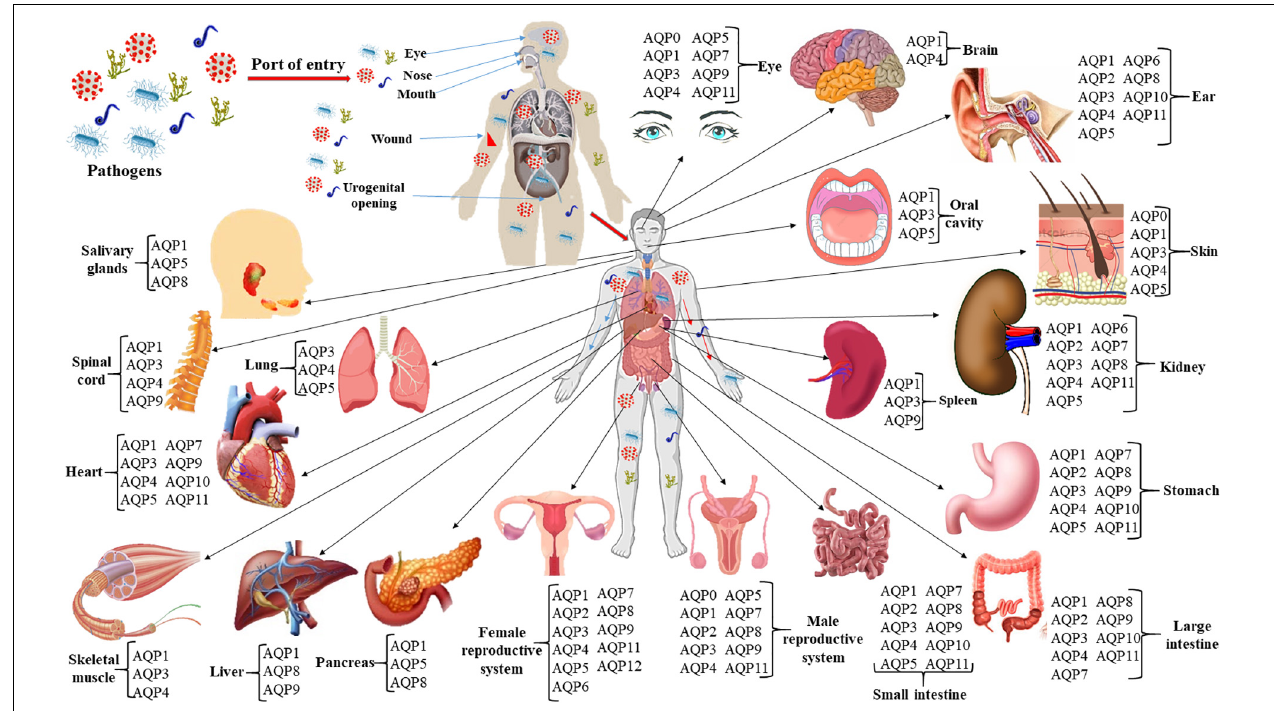
FIGURE 1 | Infection route, spreading and shedding at different organs of the body and tissue-specific distribution of AQPs. The roles of AQPs in non-infectious diseases such as different cancers and tumors, cerebral edema and ischemic stroke, obesity, renal and skin diseases, and cataracts have been widely studied. At least 10 AQPs of different organs are associated with bacterial, viral, and parasitic infections. Expressions of AQPs in infectious diseases are summarized in Table 2 of the current